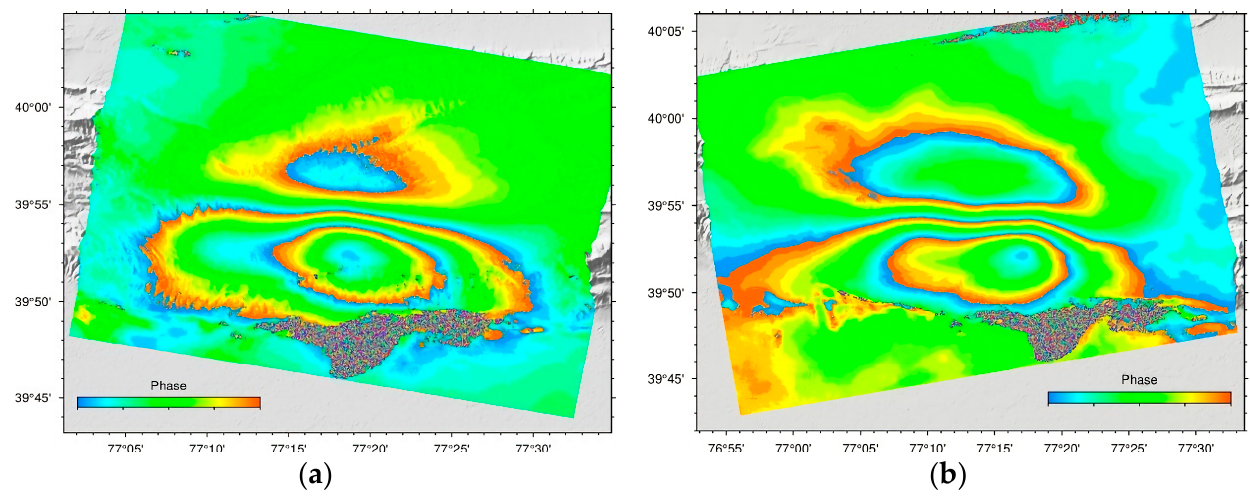
Figure 2. The line ‐ of ‐ sight (LOS) coseismic differential interferograms of the 2020 Jiashi Ms 6.4 earthquake based on the ascending and descending images from Sentinel ‐ 1A. ( a , b ) show the descending and ascending differential interferograms, respectively. Each cycle of colour (from blue to red) represents a half radar wavelength (2.8 cm) along the LOS direction.